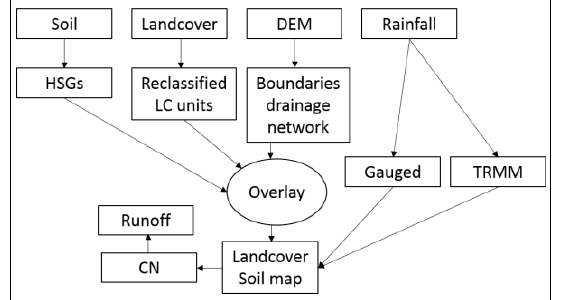
Figure 4. GIS based SCS CN